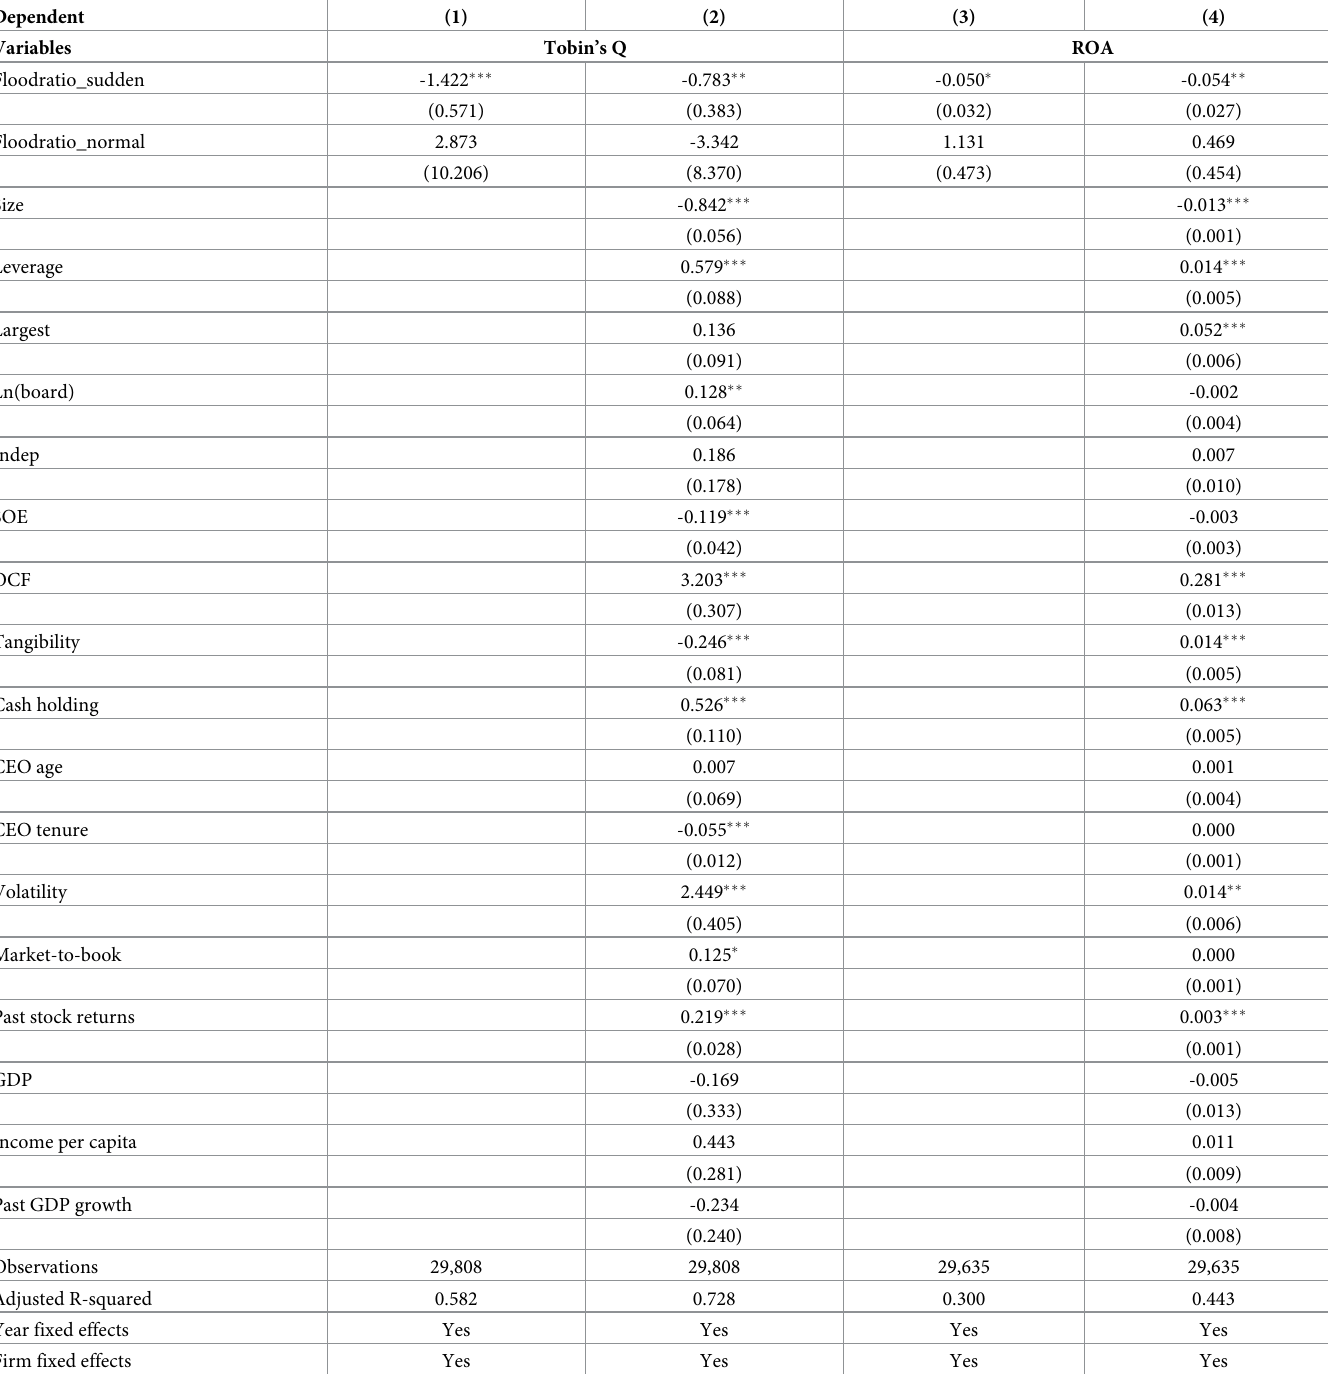
Table 4. Sudden flooding vs expected flooding. This table reports the results of the effects of both sudden flooding and expected flooding on firm performance using var- ious proxies for firm performance, including Tobin’s Q and ROA , which are measured in year t+ 1. We split our main variable of interest, flood ratio ( Floodratio ) into two variables Floodratio_sudden and Floodratio_normal . Floodratio_sudden equals Floodratio if the value of Floodratio of a city in a year is at least two-standard-deviation larger than the average Floodratio of that city (where the firm’s headquarter is located) during our sample period and equals 0 otherwise. Similarly, Floodratio_normal equals Floodratio if the value of Floodratio of a city in a year is not at least two-standard-deviation larger than the average Floodratio of that city during our sample period and equals 0 otherwise. All independent variables are measured in year t . Variable definitions are in Table A1 in the S1 Appendix. Robust standard errors are clustered at the city-year level and reported in parentheses. � , �� and ��� indicate the significance levels at 10%, 5% and 1%,